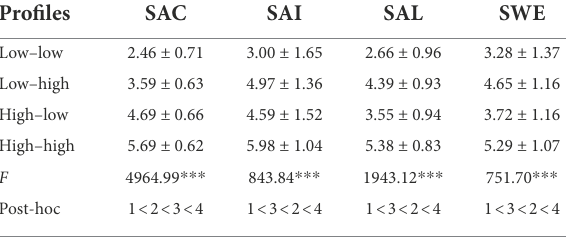
TABLE 4 Description of latent profiles ( N = 4,964).